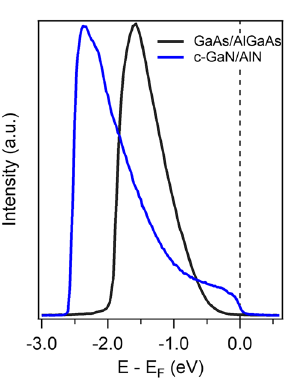
Figure 5. Comparison of the angle-integrated ARPES spectra at hv = 7 eV from the GaAs/AlGaAs heterostructure and from the c-GaN/AlN heterostructure. At the Fermi energy (0 eV), only the spectra from the c-GaN/AlN heterostructure show a non-vanishing photoemission intensity, which can be reconducted to the presence of the QW